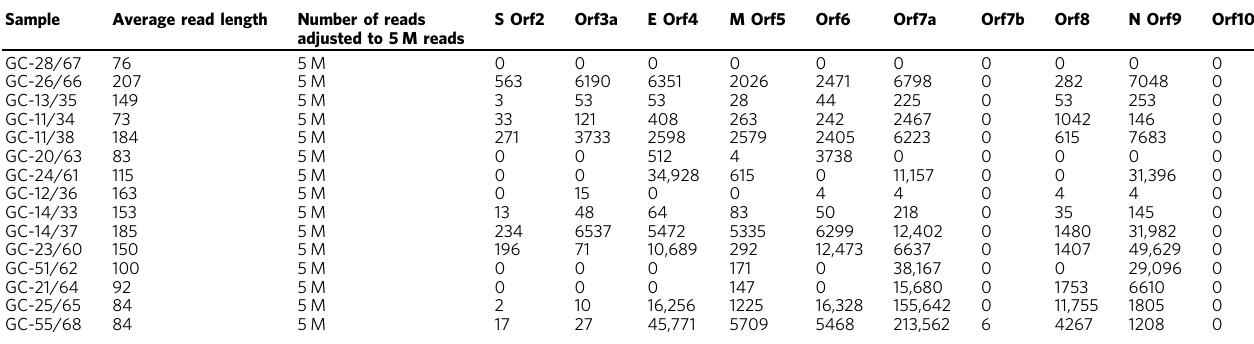
Table 3 Table showing the details of the sample number, average read length, number of reads and number of reads mapped to each subgenomic SARS-CoV-2 RNA adjusted so they represent reads normalized to a total of 5 million (5 M) reads for each sample for easier